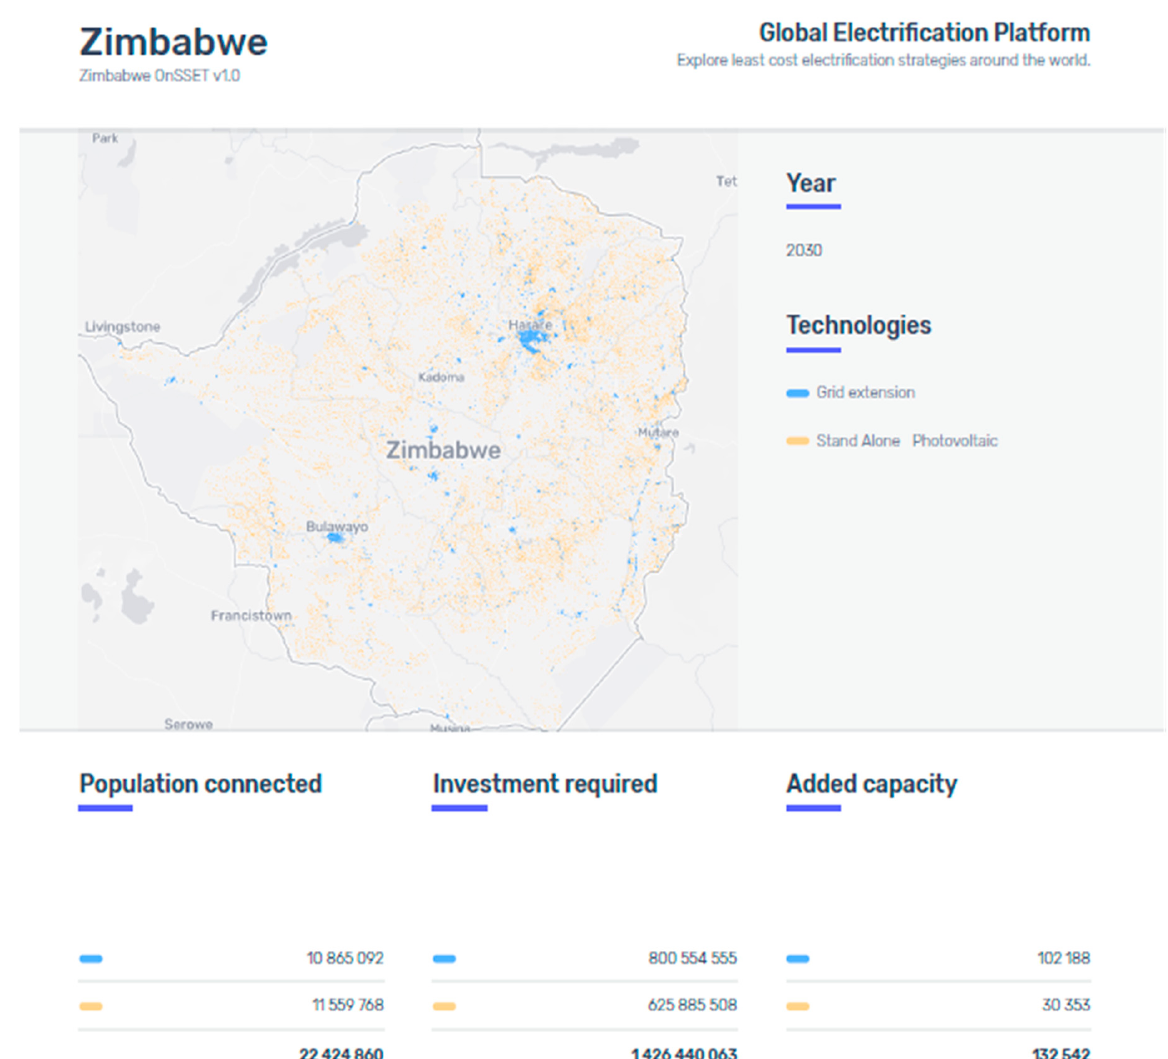
Figure 7. A full RET off-grid base electrification scenario for Zimbabwe. Source [60]. Across sectors there is a clear need to ensure that there is harmonization between hydropower planning and water and agriculture policy. Approaches to improve inter- sector planning are on the increase. Pathbreaking work for Africa quoted earlier includes Sridharan et al. [35]. However, efforts need to be made to build local capacity to undertake such analysis routinely as a part of the policy process. Work has shown that vulnerabilities can reinforce themselves, and that reinforcing—and deep vulnerability—will go unnoticed without appropriate analysis [61]. An example includes upstream water diversion and pumping for agriculture, simultaneously reducing the potential for hydropower to generate electricity while increasing the demand of electricity for pumping. In order to develop the clean adaptation strategy outlined in this report, there will need to be changes to the regulatory framework and market rules that govern the power sector and coal-purchases, as well as energy efficiency markets. These are in keeping with trends developing globally, and investigating the potential for the development of a balancing market is, thus, recommended. Such a market should allow conventional power plants to act (or be retrofitted to act) in a manner to allow the power system to absorb electricity from lower carbon intermittent sources such as wind and solar and, while performing the balancing (rather than primarily producing power), they should be financially rewarded. When there is high concurrent production of wind, solar and